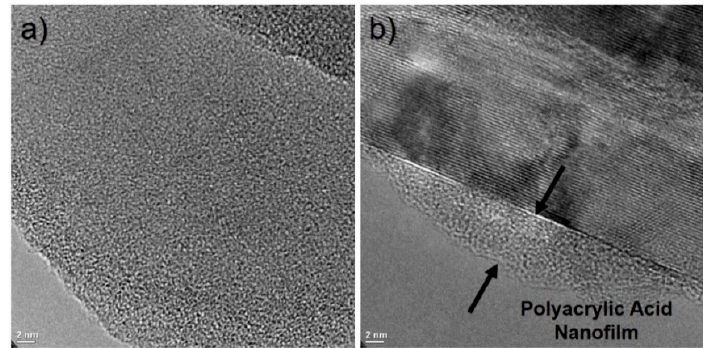
Figure 4. HR-TEM micrographs of: ( a ) unmodified (h-BN) and ( b ) plasma-modified (mh-BN) nanoparticles.